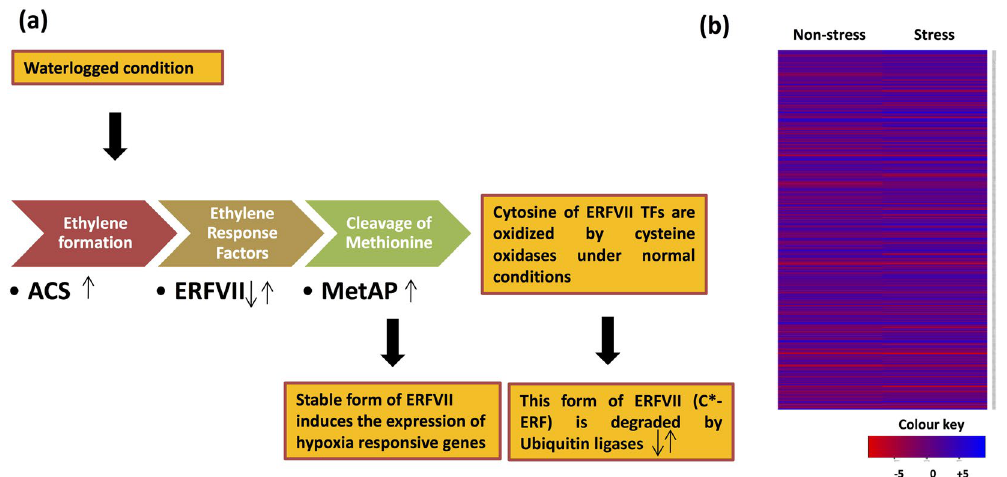
Figure 5. Ethylene-responsive pathways regulated in waterlogging tolerant genotype under stressed conditions. (a) Ethylene-responsive pathways regulated during waterlogging stress. Here arrows denote the expression level of waterlogging responsive genes in maize roots. Expression level marked here includes greater than 2 fold change. Refer the paper for abbreviations. (b) Heatmap of ethylene-responsive pathway regulating genes. X-axis denotes non-stress and stress conditions. Y-axis denotes the gene models of ethylene-responsive pathway genes. Refer Table S7 for details of ethylene-responsive pathway